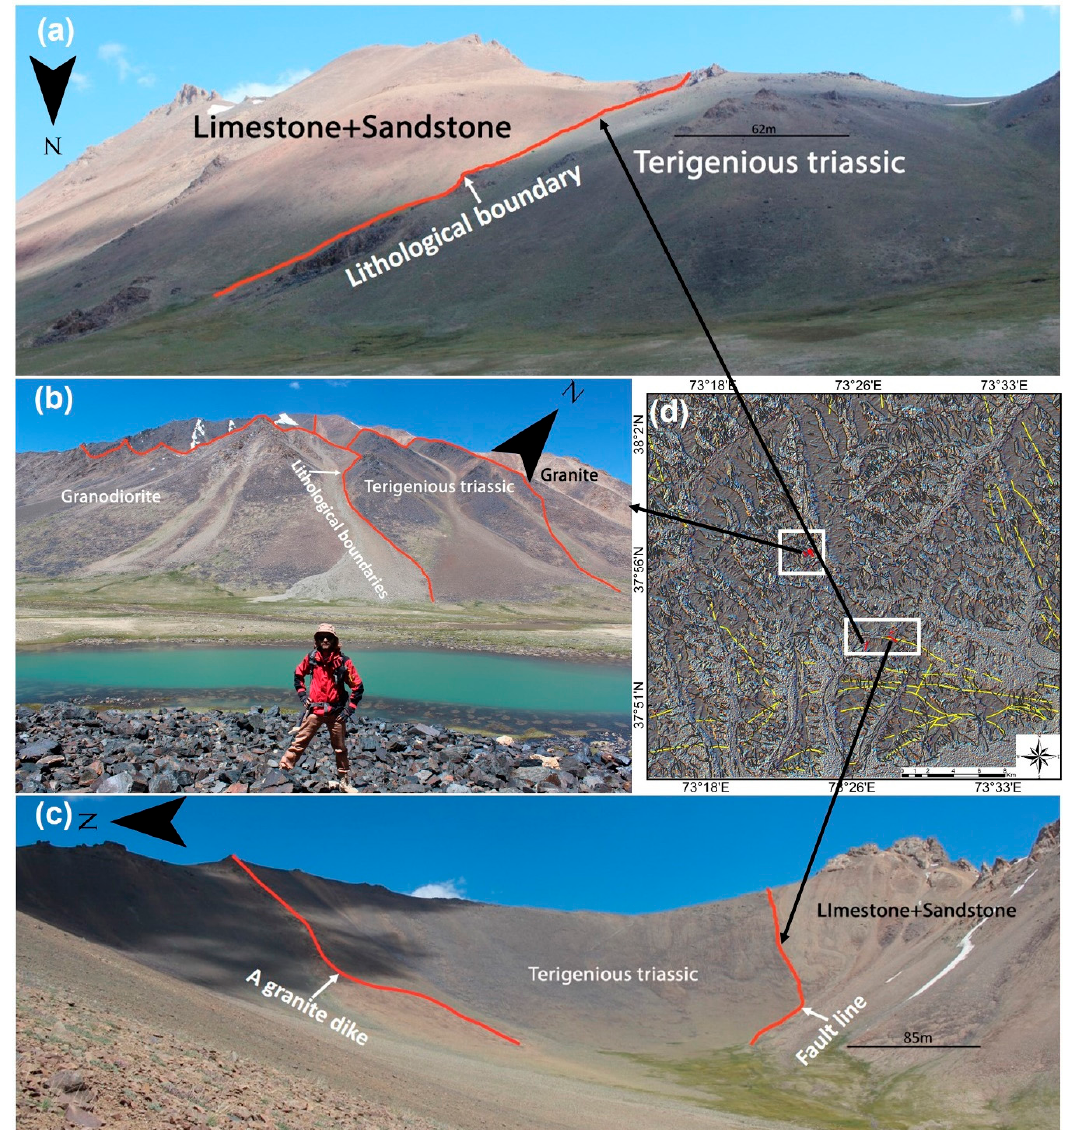
Figure 7. Some examples of verified lineaments in the field: ( a – c ) Field photographs of the verified lineaments, ( d ) directionally filtered PGB image of S1A VH polarization with lineaments extracted (in black), verified lineaments (in red), and digitized fault lines (in yellow).